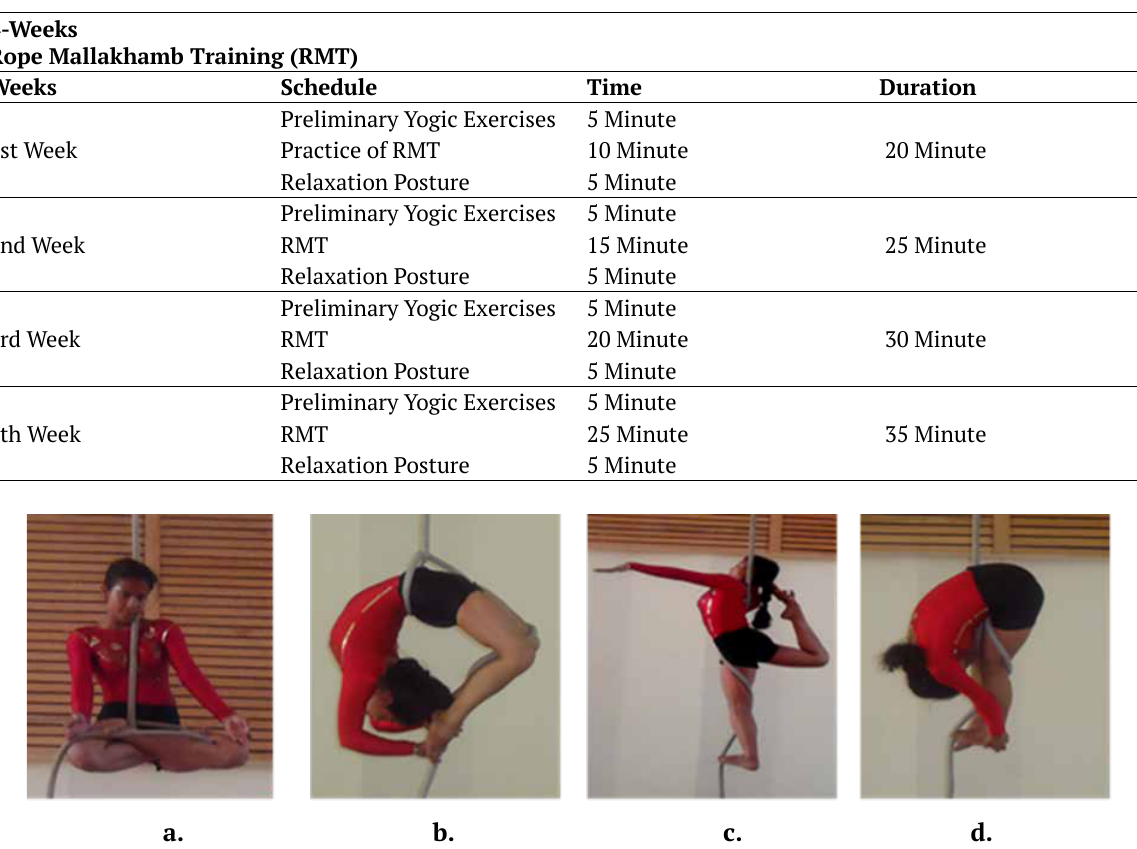
Figure 3. Selected asanas (a) Padmasana, (b) Dhanurasana, (c) Natrajasana and (d) Padhastasana